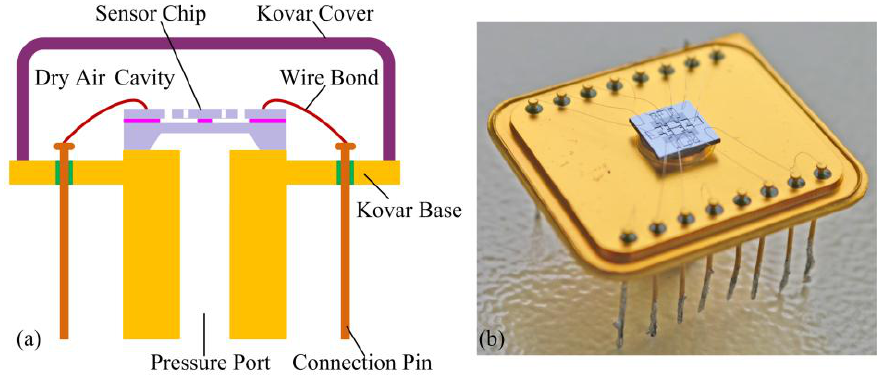
Figure 9. ( a ) Schematic drawing of the resonant pressure sensor package. ( b ) Picture of the resonant pressure sensor package before hermetic sealing.